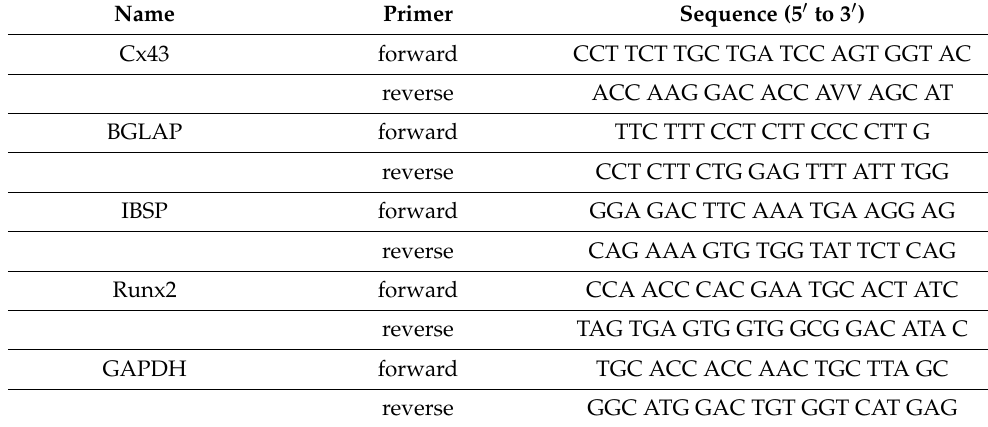
Table 1. Summary of pPCR